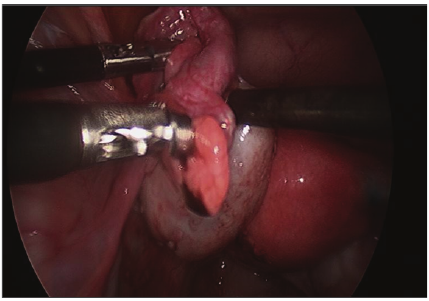
Figure 1: Endoscopic picture of MLF procedure; right angle cystic duct clamp inserted halfway into